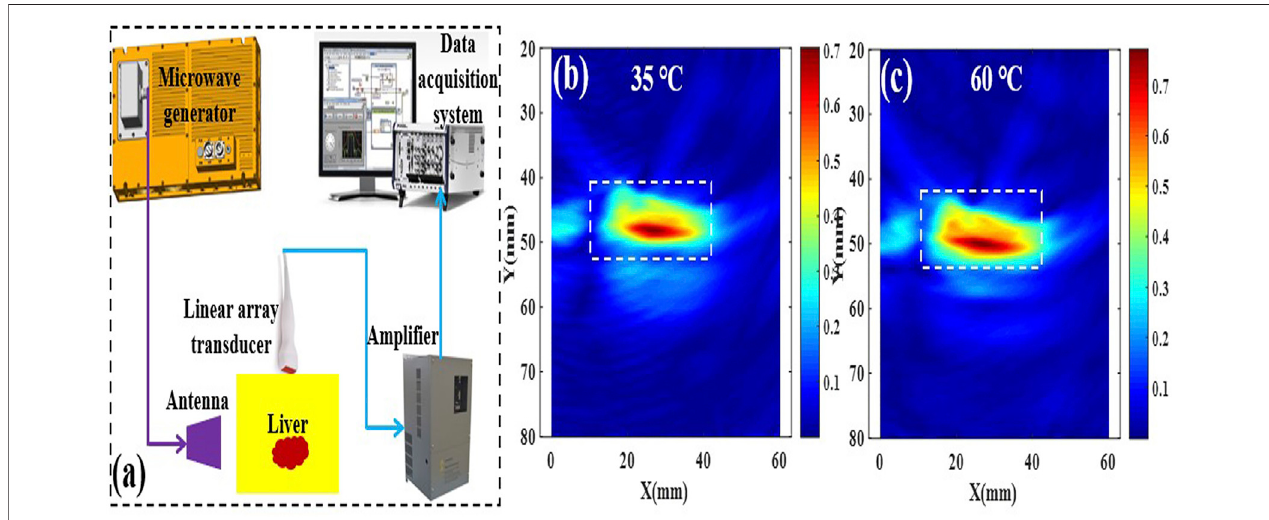
FIGURE 3 | Schematic of the TA imaging system (A) , and the corresponding TA images of porcine liver tissue at 35 and 60 ° C (B,C) .